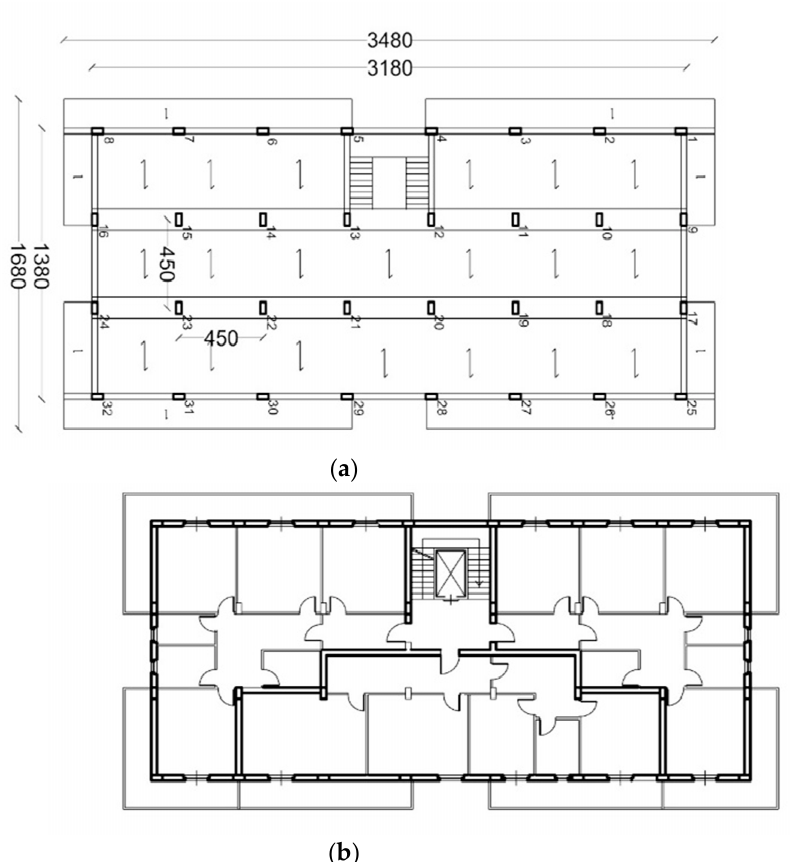
Figure 1. Generic architectural ( a ) and structural ( b ) plan of the case study.